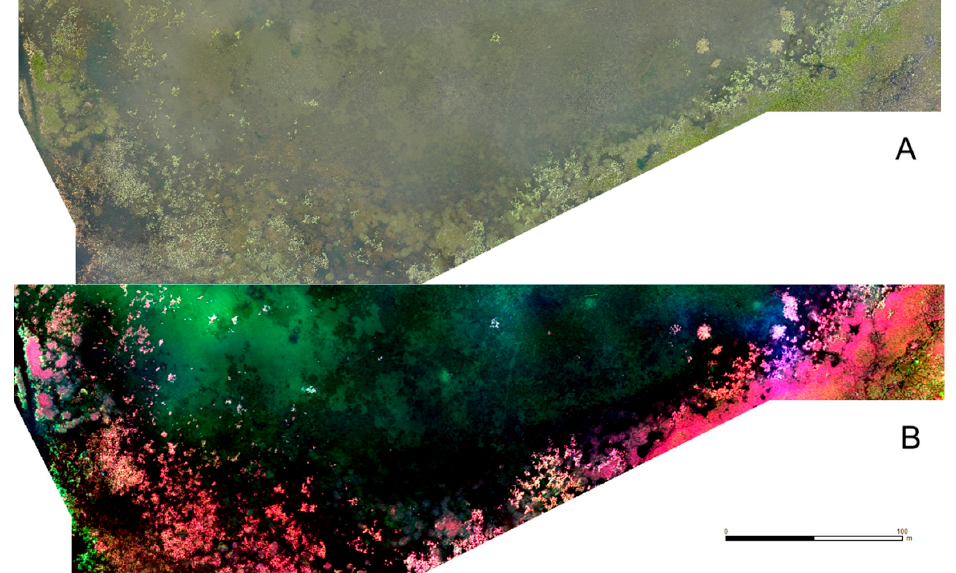
Figure 3. Example true-color RGB orthomosaic ( A ) and false-color CIR reflectance map ( B ) of study site 2.